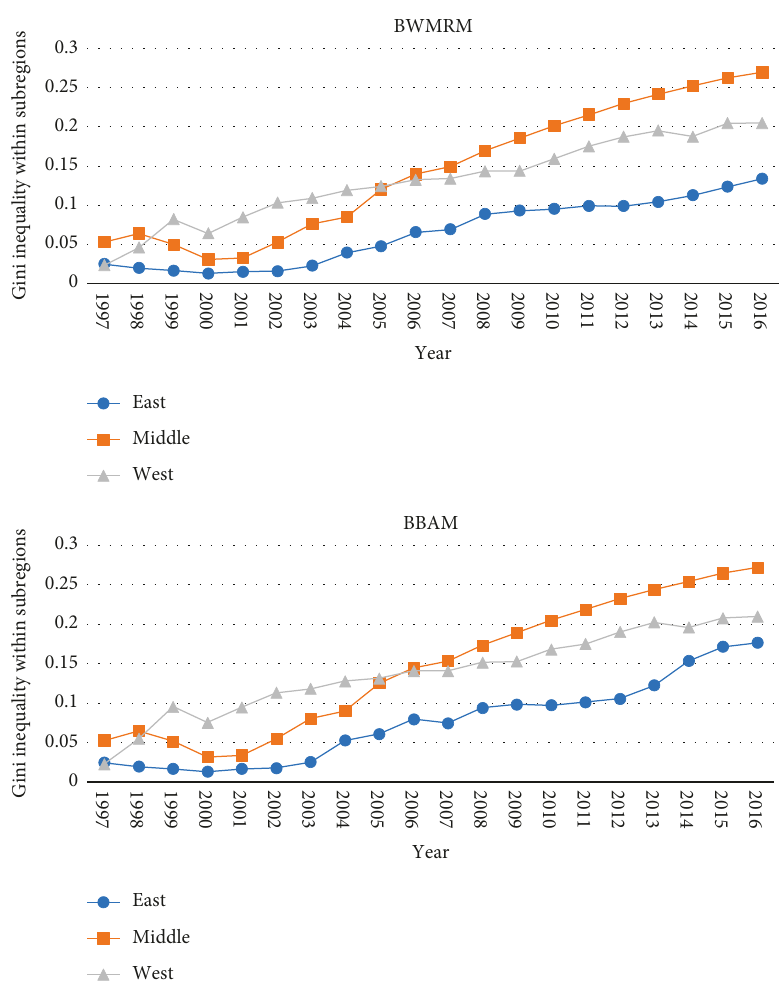
Figure 3: The dynamic change of Gini inequality within subregions of AGTFP in